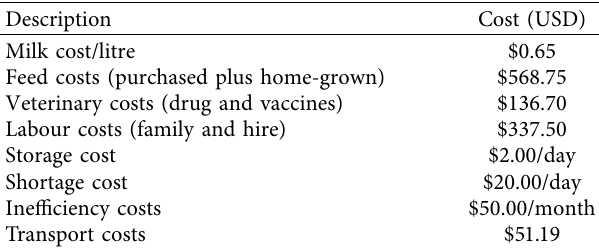
Table 7: PCA for feed and associated costs